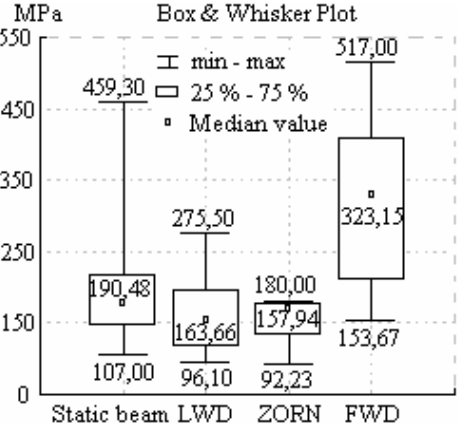
fig. 11. Dispersion plot of the measuring results on the frost blanket course (left side)